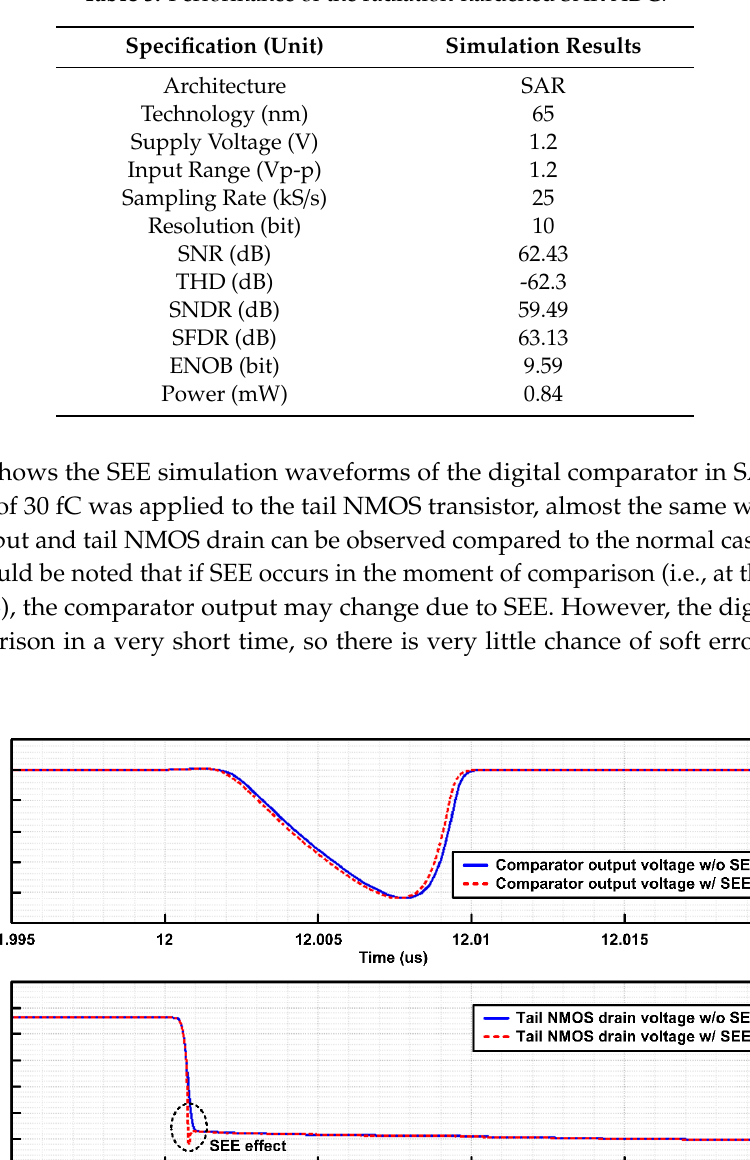
Table 3. Performance of the radiation-hardened SAR ADC.